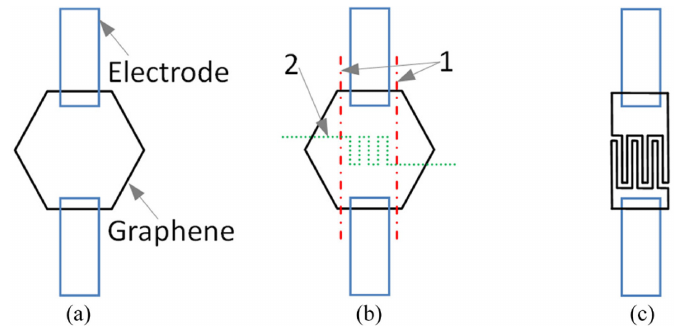
Figure 5. The cutting path design. ( a ) Graphene assembled on microelectrodes; ( b ) sequence of cutting paths; and ( c ) structure of the graphene interdigitated electrodes.